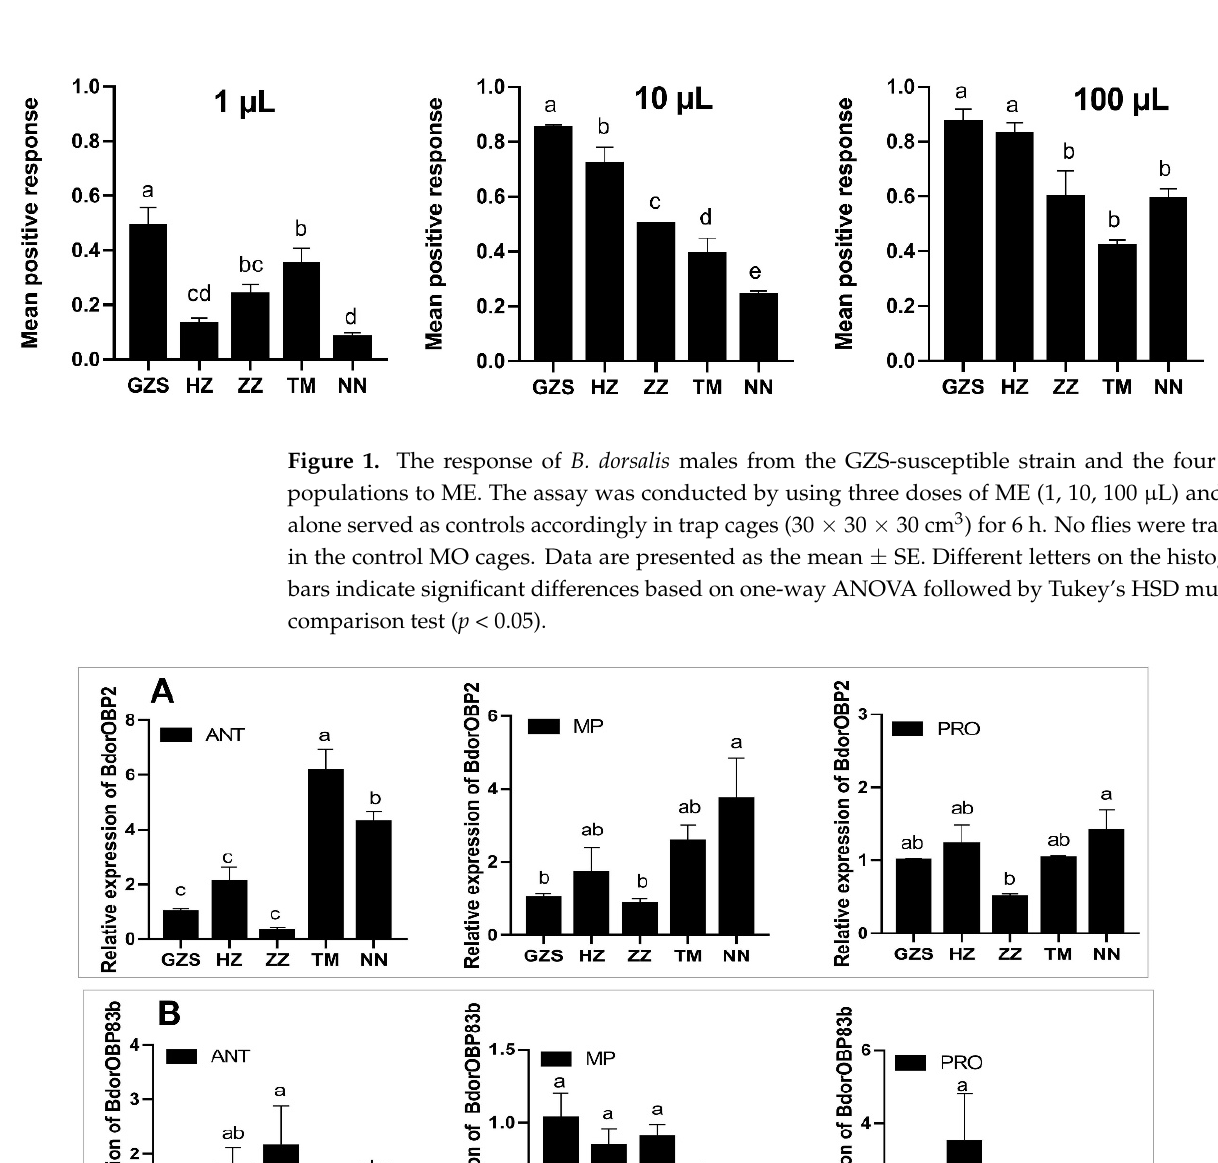
Figure 2. Expression profiles of four genes in the antennae (ANT), maxillary palps (MP) and proboscis (PRO) of B. dorsalis males from the GZS susceptible strain and the four field populations ( A ) BdorOBP2, ( B ) BdorOBP83b, ( C ) BdorOrco, and ( D ) BdorOR88a. Relative gene expression was measured by qRT ‒ PCR, and values represent the means ± SEs for three independent replicates. Different letters on the histogram bars indicate significant differences based on one ‐ way ANOVA followed by Tukey’s HSD multiple comparison test ( p < 0.05).